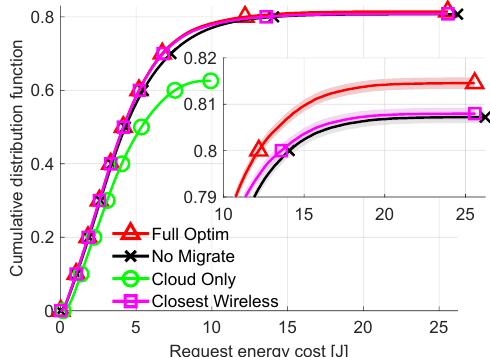
Figure 7. Comparison of energy consumption per request (CDF). Delay requirement: 700 ms.